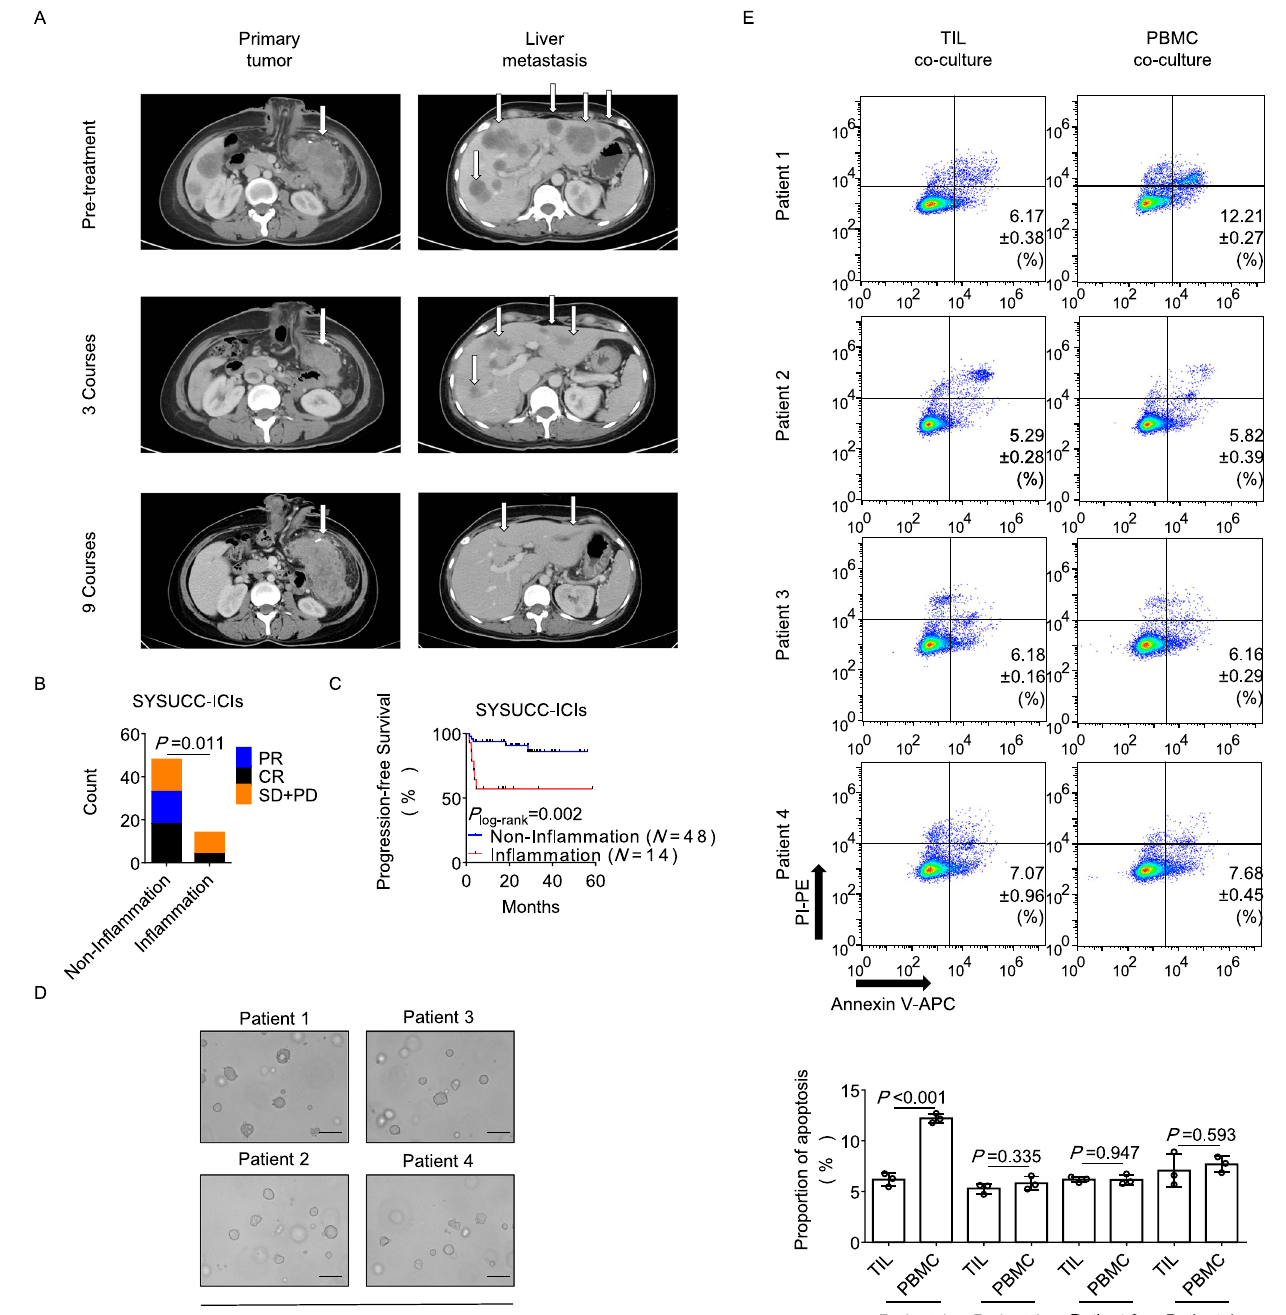
Fig. 1 | In fl ammatory conditions are associated with poor response to PD-1 blockade in dMMR/MSI-H CRCs. A CT scans were conducted on Patient 1 after 0 courses, 3 courses and 9 courses of treatment. Images of the primary tumor and metastatic lesions are shown. Tumor lesions are marked by arrows. B , C Tumor response ( B ) and progression-free survival ( C ) after PD-1 blockade were compared between MSI-H CRC patients with ( N =14) and without ( N =48) in fl ammatory conditions. The Wald chi-square test ( B ) and Kaplan-Meier method with Log-rank test ( C ) were used. D Bright fi eld (Scale bar: 100 μ m) images of tumor organoids